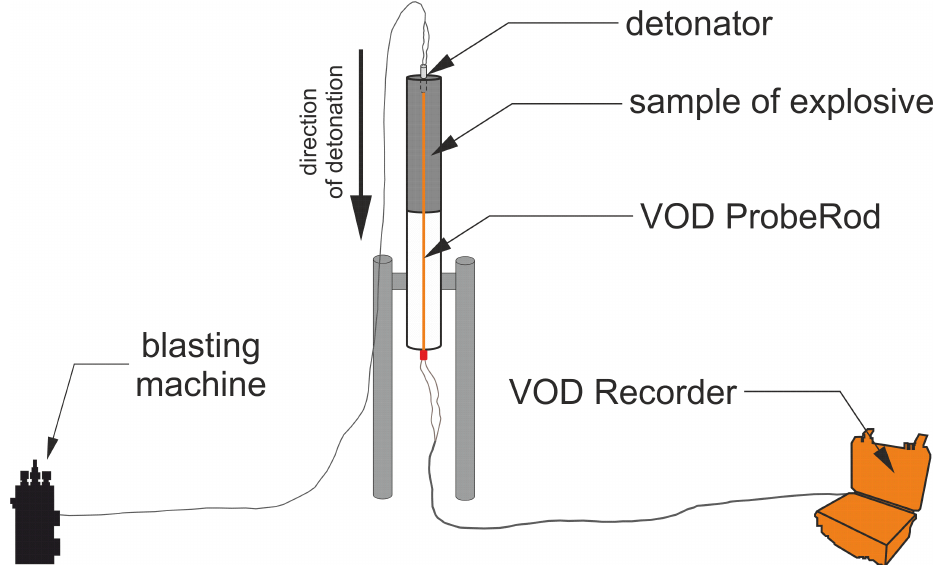
Figure 2. Schematic depiction of the experimental set-up for measuring velocity of